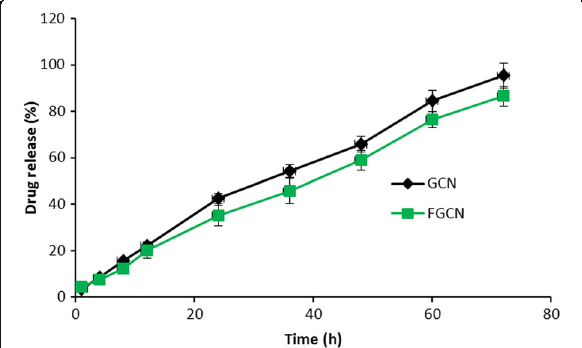
Fig. 3 In vitro release profile of GCN and FGCN in phosphate buffered saline (pH 7.4). The amount of drug released was quantified by HPLC method, and the experiment was performed in triplicate